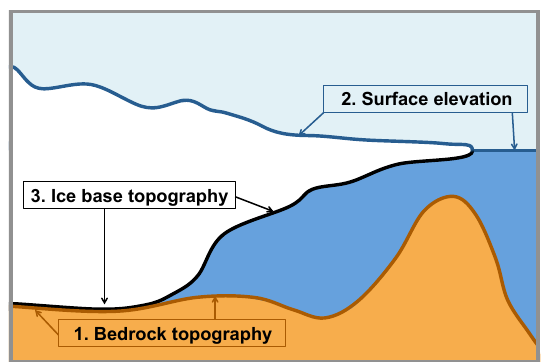
Figure 1. Sketch of a 2-D vertical section along a floating glacier tongue/ice shelf with grounded and floating ice (white), sub-ice bedrock/ocean seafloor (brown), and water in a subglacial cavity and the open ocean (blue). Lines indicate the bedrock topography (brown), the surface elevation (dark blue), and the ice base topogra- phy (black).